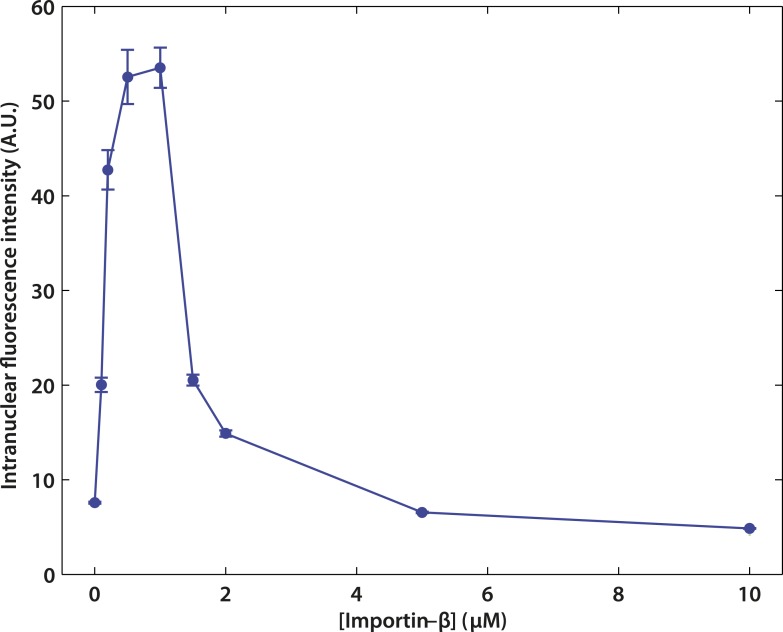
Effect of impβ concentration on active transport.The optimum concentration was ∼1 μM. At low impβ concentrations, cargo•impβ complex formation is limited by impβ availability, leading to low import levels. At high impβ concentrations, competition for NPC binding sites between free impβ and the cargo•impβ complexes leads to reduced import efficiency.